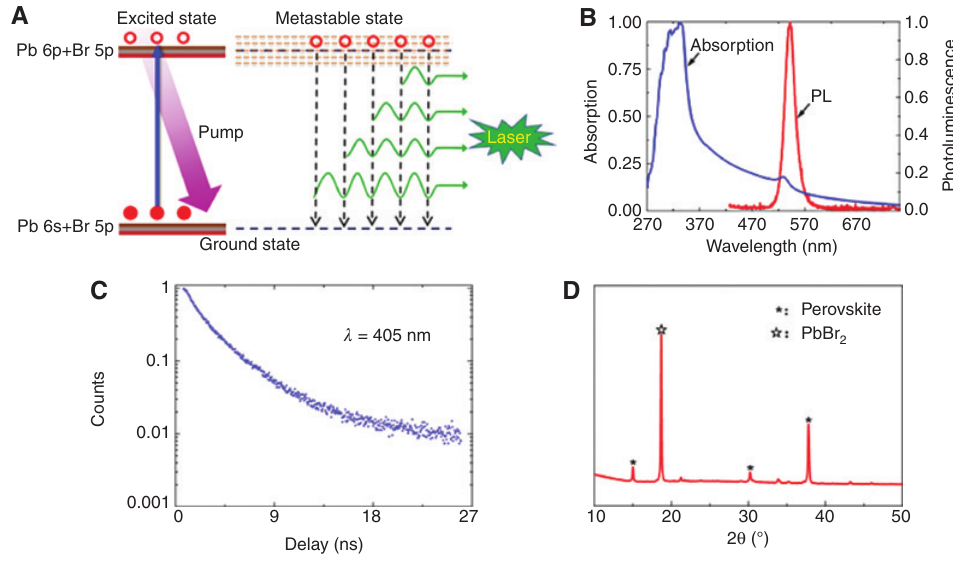
Figure 2: Spectral characterizations of the perovskite. (A) Energy diagram of the proposed perovskite (MAPbBr perovskite film. (D) XRD pattern of the perovskite